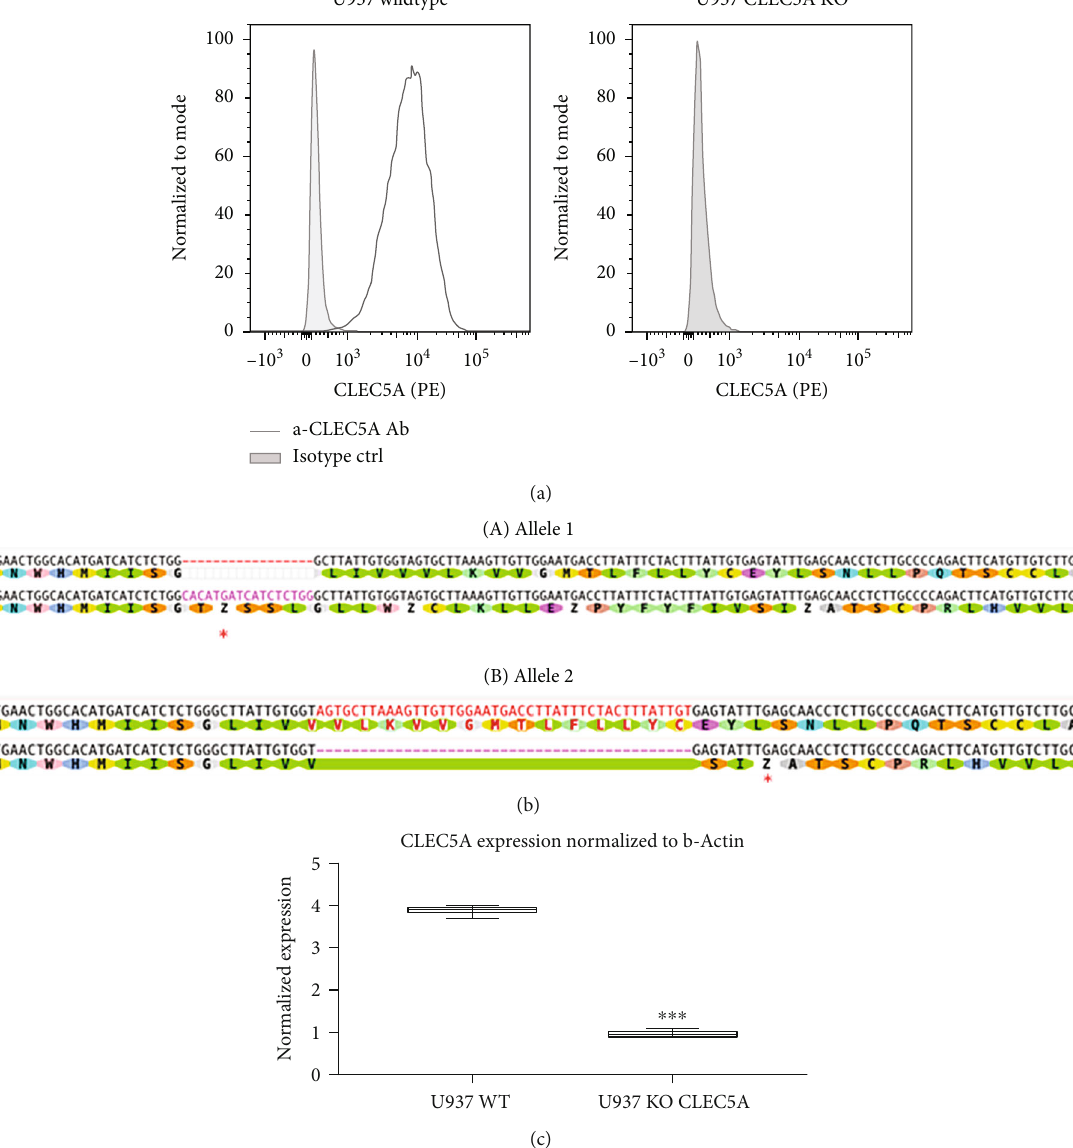
Figure 1: Monoclonal α -CLEC5A Ab clone # 283834 binds to U937 wild-type (WT) but not to CLEC5A-de fi cient (CLEC5A KO) U937 cells. (a) WT (A) or CLEC5A KO (B) U937 cell line was fi rst di ff erentiated with 10nM PMA for 3 days and then incubated 15min either with a PE-labelled α -CLEC5A Ab or with its corresponding isotype ctrl. α -CLEC5A Ab (grey line) vs isotype (grey shadow) binding in FACS is shown as a histogram overlay. (b) CRISPR/Cas9-mediated knockout of CLEC5A at exon 2 in U937 cells was con fi rmed by sequencing of genomic DNA around the targeted locus. Alignment of CLEC5A WT locus and clone 2.11 CLEC5A KO shows a 17bp insertion (a, allele 1) and 43 bp deletion (b, allele 2) leading in both cases to a premature stop codon ( ∗ ) leading to translation termination. (c) The U937 WT and CLEC5A KO cells were di ff erentiated with PMA as described above. RNA from the di ff erentiated cells was extracted, reverse transcribed, and screened for mRNA levels by real-time qPCR for CLEC5A and β -actin (housekeeping gene) as a reference. Values represent the mean ± SD from three technical replicates; ∗∗∗ p < 0 : 001